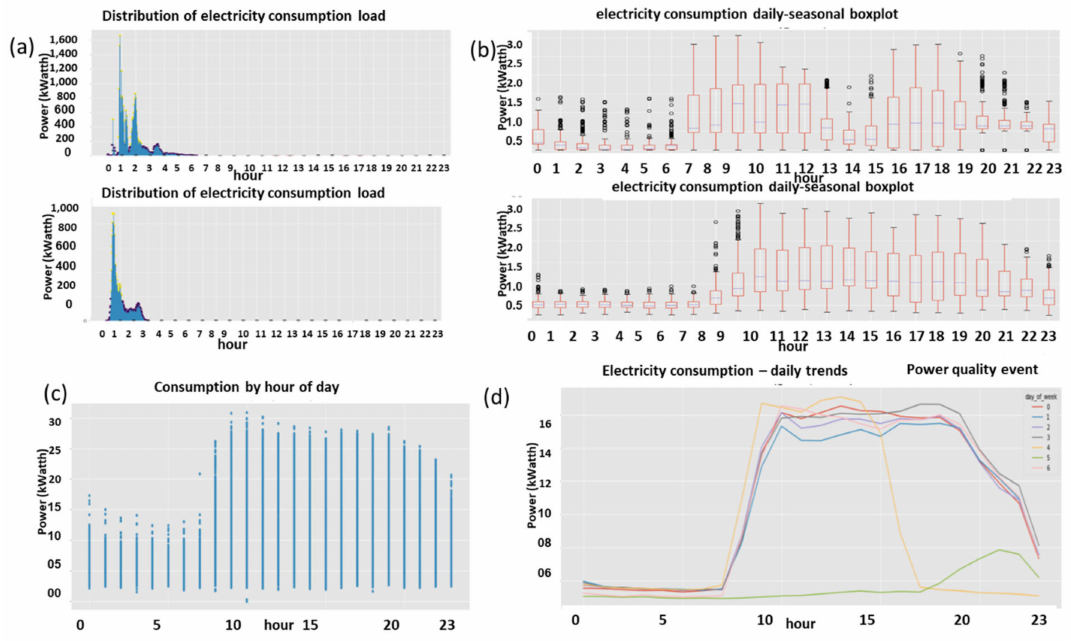
Figure 19. Sample feature graphs of Module 1 when there is an abnormal multitude of power quality events. ( a ) Energetic distribution, ( b ) seasonal-hourly boxplot, ( c ) hourly scatter, ( d ) daily- hourly